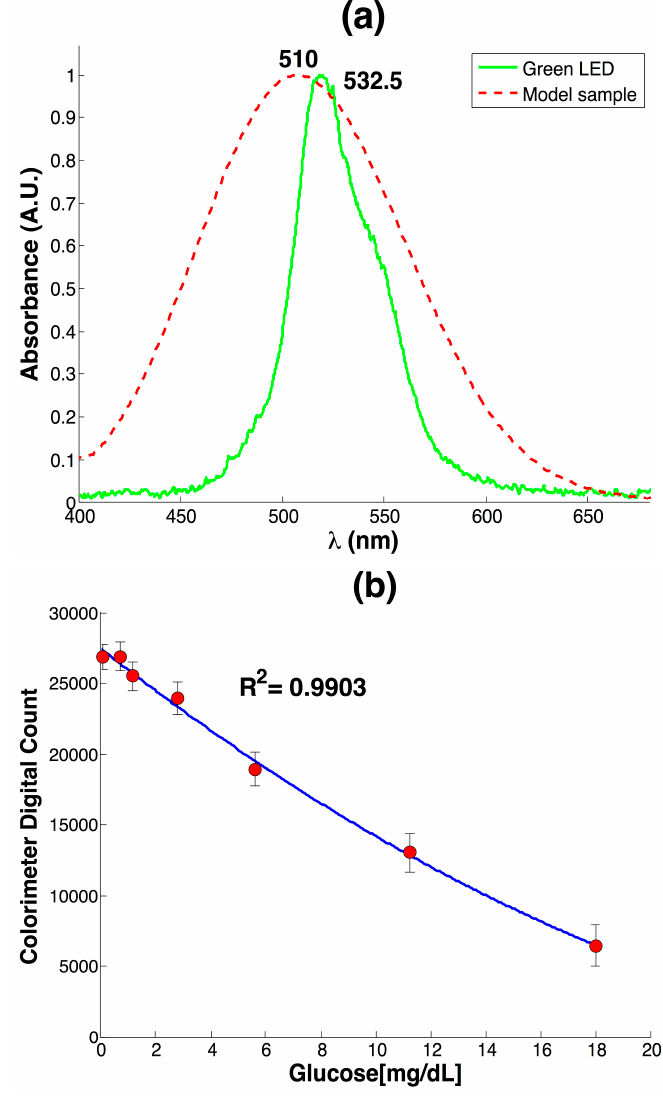
Figure 2. ( a ) The recorded emission specter of the green LED compared with the absorbance specter for 18 mg/dL sample; ( b ) The calibration curve obtained for glucose detection with the RGB colorimeter.